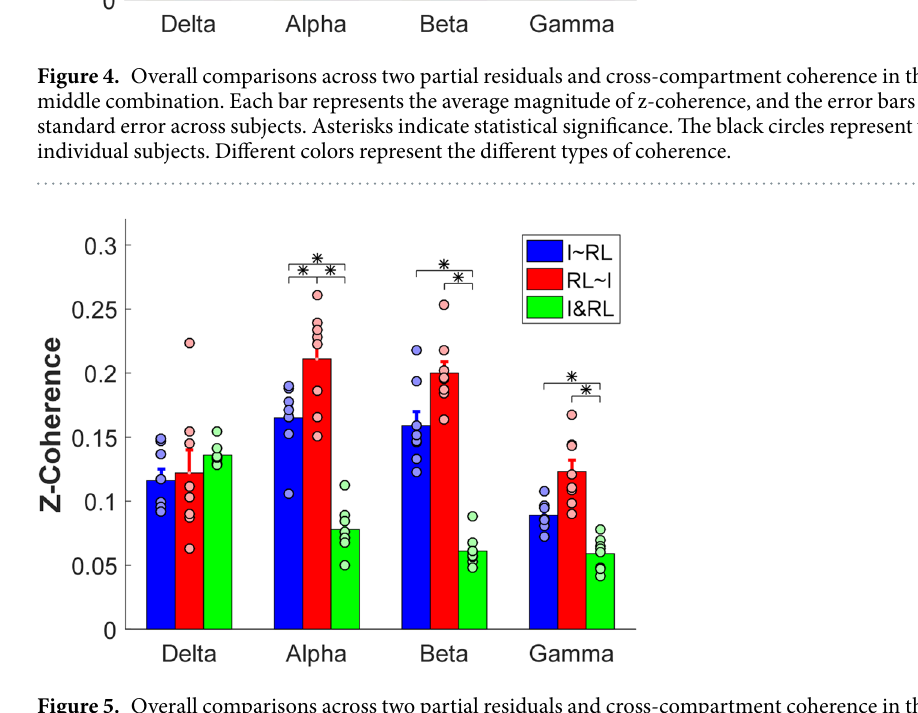
Figure 5. Overall comparisons across two partial residuals and cross-compartment coherence in the index vs. ring-little combination. Each bar represents the average magnitude of z-coherence, and the error bars represent standard error across subjects. Asterisks indicate statistical significance. The black circles represent values of individual subjects. Different colors represent the different types of